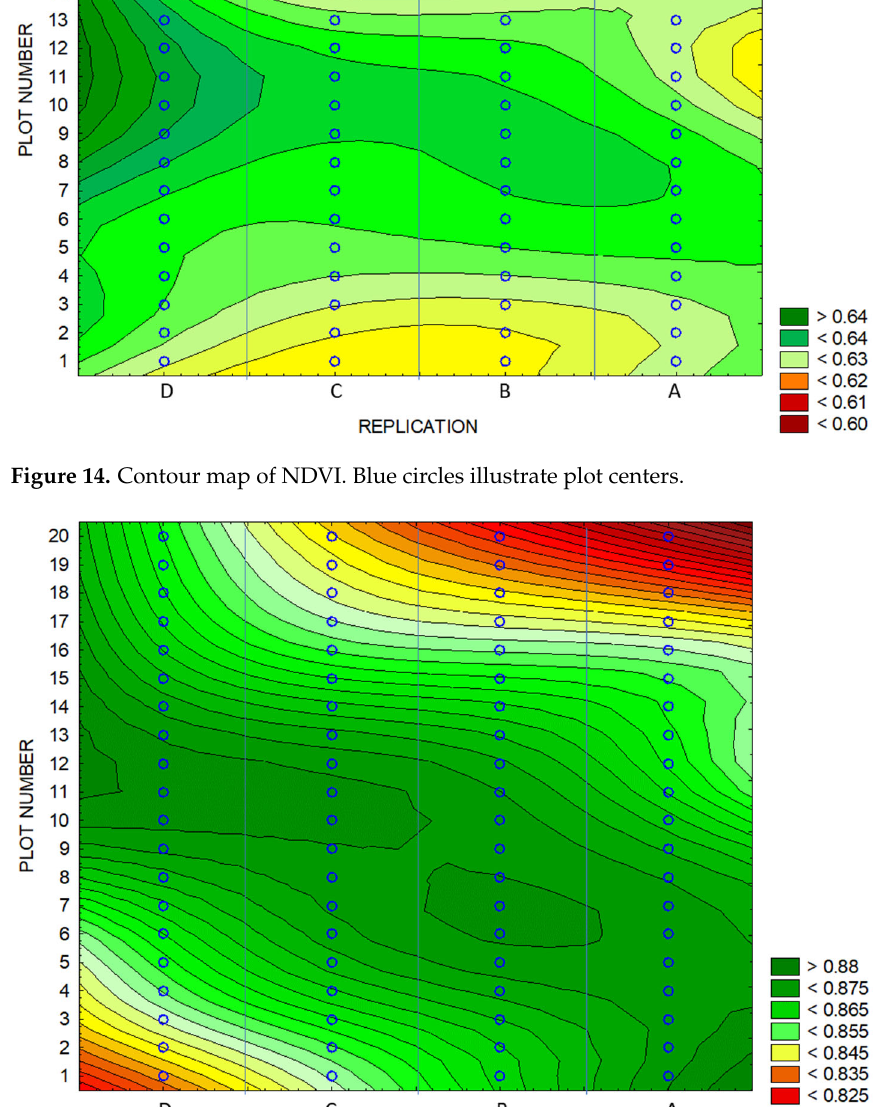
Figure 16. Contour map of NDYI. Blue circles illustrate plot centers.